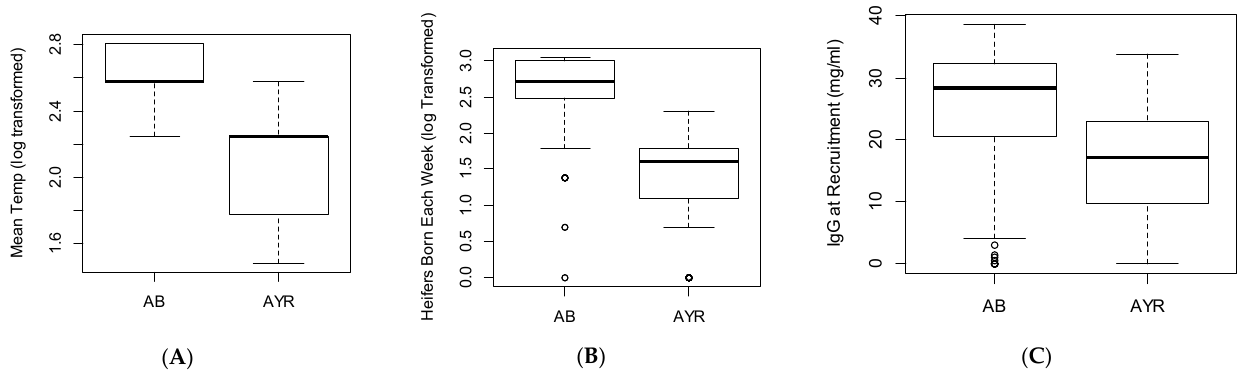
Figure 1. Box and whisker plots showing significant relationships between calving pattern (autumn block, AB, n = 3 farms or all year round, AYR, n = 8 farms) and other variables tested. ( A ) Mean temperature in the month of calf birth. ( B ) Calving intensity (number of heifers born in the same week, analysed and plotted on a logarithmic scale) and ( C ) passive transfer measured by serum immunoglobulin (IgG) at recruitment. These were all highly significant in a linear model ( p < 0.001). Boxes show the median, 25th and 75th centile, whiskers indicate the minimum and maximum values, with ○ as outliers.